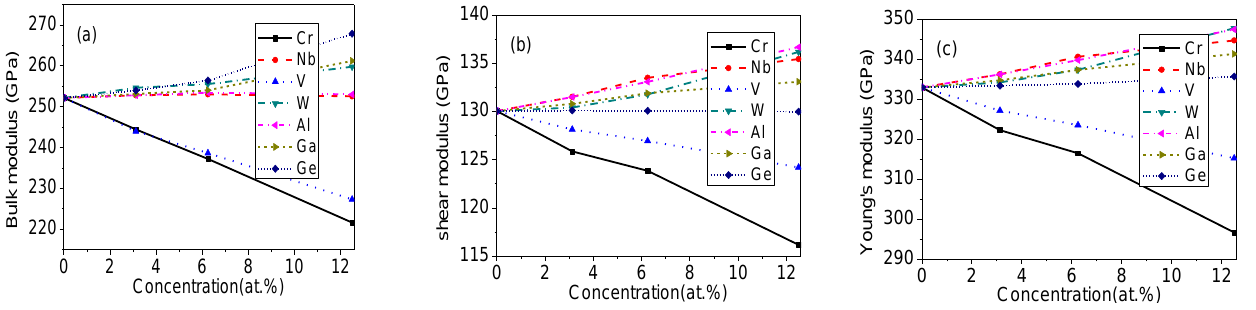
Figure 3. Mechanical properties of doped Mo 3 Si. ( a ) bulk modulus; ( b ) shear modulus; ( c ) Young’s modulus.